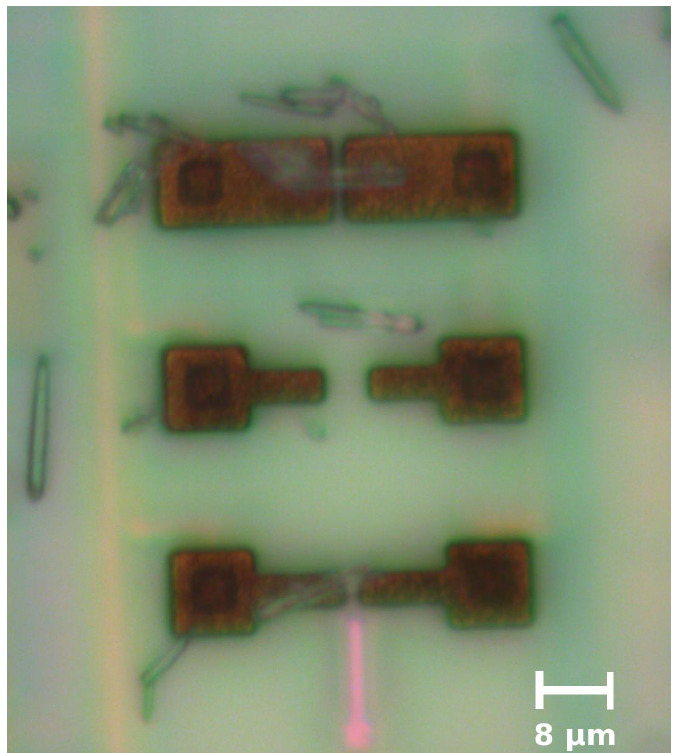
Figure 8. Example of a ZnO-NW successfully integrated onto M4N chip (upper electrode pair).